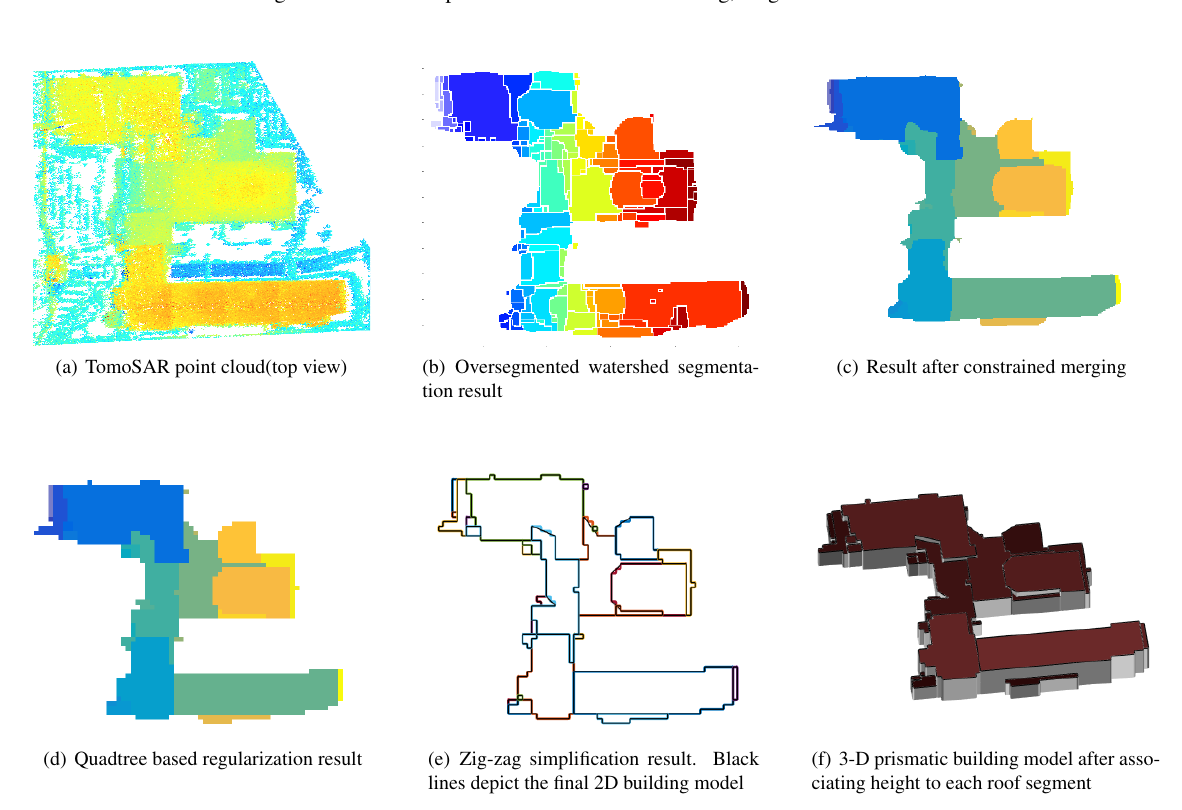
Figure 3: TomoSAR point clouds of the test building, height is color coded.